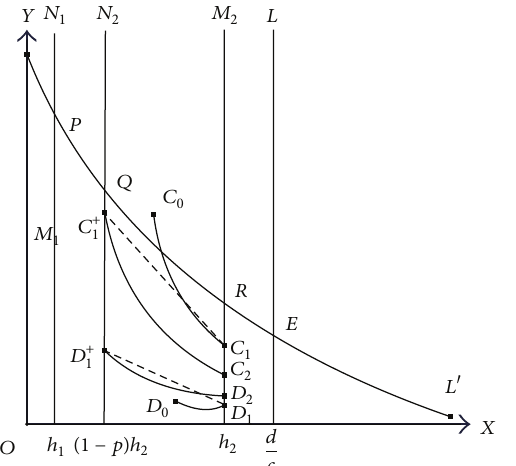
Figure 15: The orbit starting from the point 𝐶 0 (Case 3(b) in Section 4.1.3).